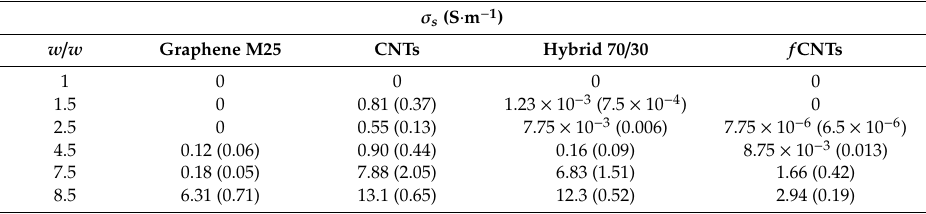
Table 2. The σ s of PEGDA / carbon nanofiller composites in various carbon nanofiller percentage.